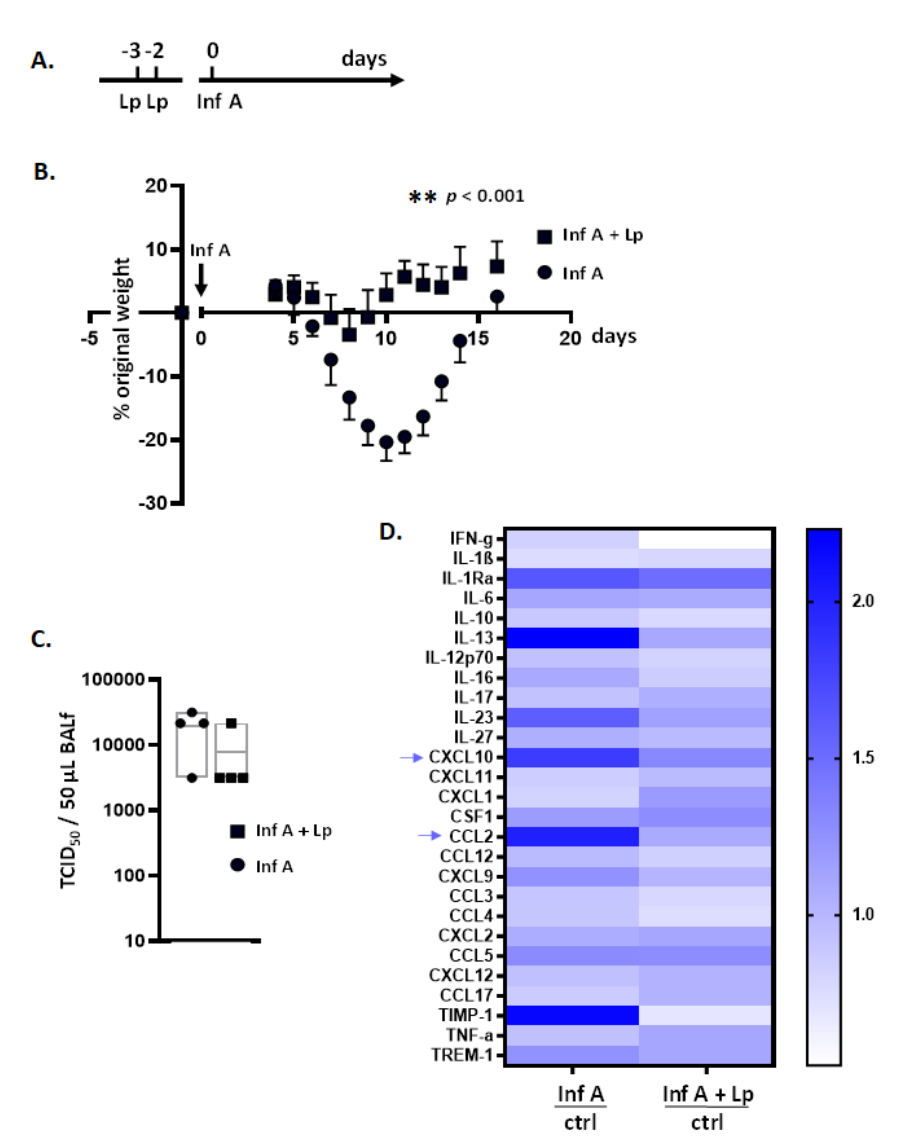
Figure 1. Lactobacillus plantarum (Lp) administered to the respiratory tract protects mice against inflammation and weight loss in response to infection with Influence (Inf) A. ( A ) Experimental protocol. Mice were inoculated intranasally with Lp (10 8 cells in 50 µL) or diluent control on days − 3 and − 2 followed by Inf A (30 TCID 50 units in 5 µL, 2.5 µL per nare) on day 0. ( B ) Weights on days 4–16 normalized to weights on day 0; n = 5 mice per group, ** p < 0.01 on days 7–14, two-way ANOVA. ( C ) Virus detected in BAL fluid on day 8 after priming with Lp or diluent alone followed by inoculation with Inf A, as per the protocol shown in ( A ). ( D ) Heat map documenting the results of cytokine profiling of pooled BAL fluid collected from mice primed with Lp or diluent alone followed by inoculation with Inf A or diluent alone ( n = 5 mice in each of four groups), as per the protocol shown in ( A ) and evaluated on day 8. Raw data for each cytokine mediator were normalized to the diluent/diluent (i.e., no Lp and no Inf A); p < 0.05.